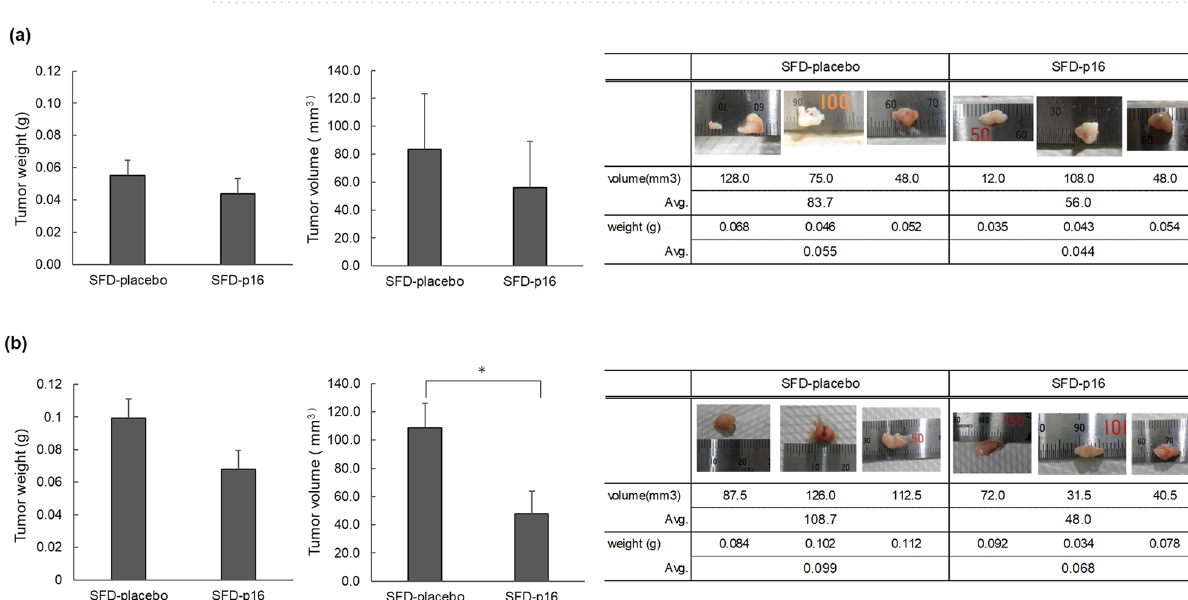
Figure 3. Tumor weight and volume in nude mice with subcutaneous transplantation of A549 cells ex vivo and in vivo after SFD powder treatments. ( a ) Ex vivo test. After treating A549 cells with SFD-p16 or SFD-placebo, subcutaneous transplantation was performed. One week later, tumor weight and volume were measured and compared. No significant difference was observed; however, tumors in the SFD-p16 group tended to be lighter. The data represents the means ± SD (N = 3). Mean values were compared using a one-tailed Student’s t-test. ( b ) In vivo test. Tumors formed after subcutaneous transplantation were treated with SFD-p16 and SFD-placebo. One week after treatment, the tumor weight and volume were measured and compared. Tumors in the SFD- p16 group were significantly smaller. The data represents the means ± SD (N = 3). * p < 0.05. Mean values were compared using a one-tailed Student’s t-test. Avg.: